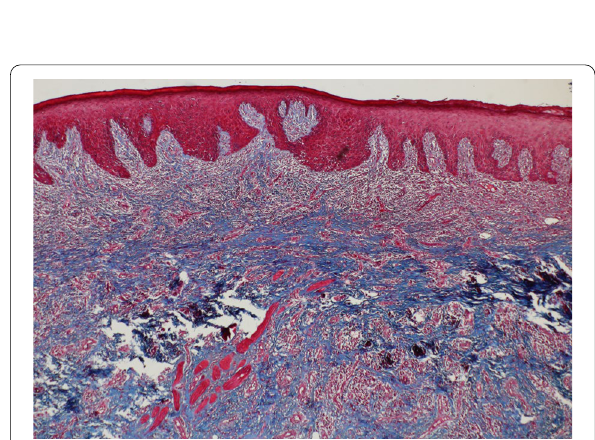
Fig. 5 Masson’s trichrome staining revealed distinct fibrosis, especially around infiltrated lymphocytes in the subepithelial